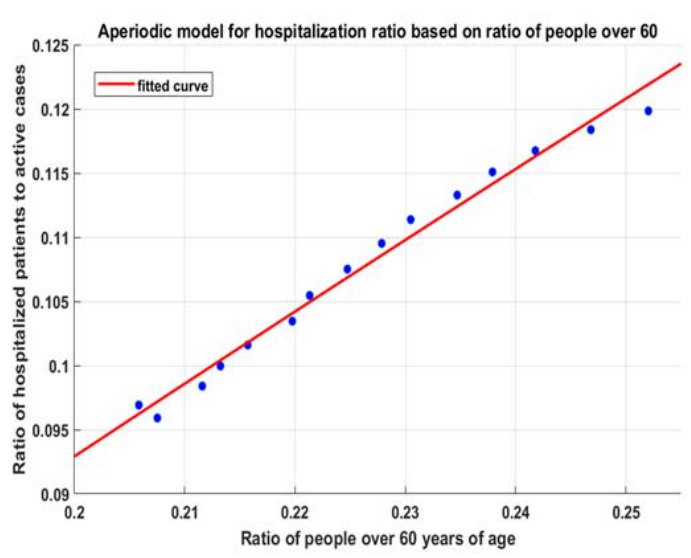
Figure 5. Fitted model (9) for hospitalizations.